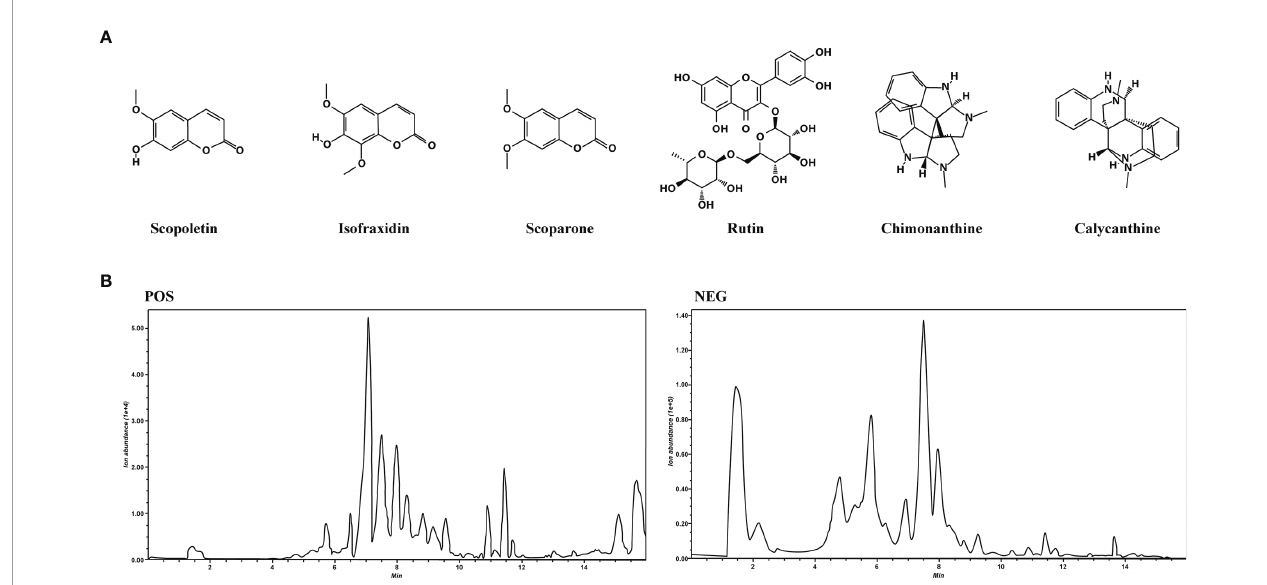
FIGURE 2 | Analysis of the components of Chimonanthus nitens Oliv. leaf granule. (A) The chemical structure of scopoletin, isofraxidin, scoparone, rutin, chimonanthine, and calycanthine. (B) Total ion chromatogram of C. nitens Oliv. leaf granule in positive and negative ion modes.